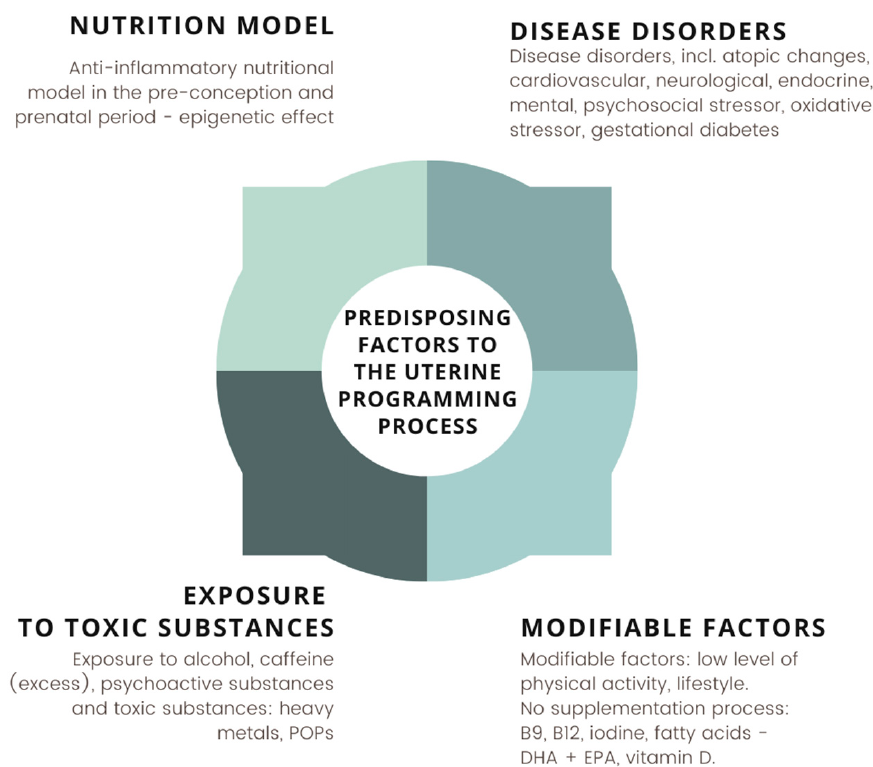
Figure 5. Factors predisposing to the uterine programming process in the critical phase of fetal development. Own elaboration based on [3,9–12].